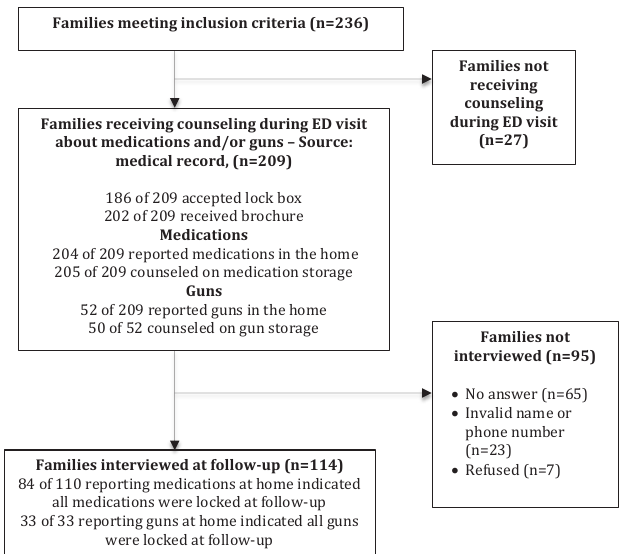
Figure. Receipt of counseling, participation in follow-up interviews, and family reports of storage